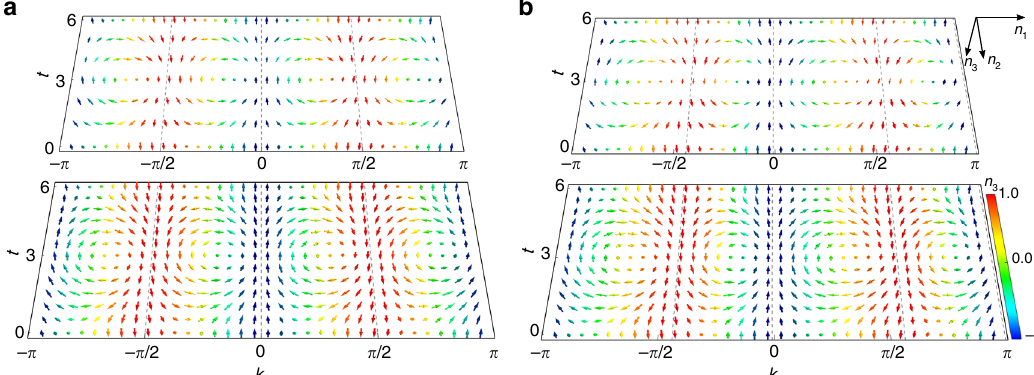
Fig. 4 Experimental results of spin texture n ( k , t ). Experimental (upper layer) and theoretical results (lower layer) of spin texture n ( k , t ) in the momentum – time space for quench processes corresponding to ( a ) Fig. 3a, and ( b ) Fig. 3b, respectively. The temporal resolution of experimental measurements is limited by discrete time steps of QWs, whereas we apply a better resolution in theoretical results for a clearer view of skyrmions. The spin textures are colored according to n 3 ( k , t ) and fi xed points are indicated by dashed lines